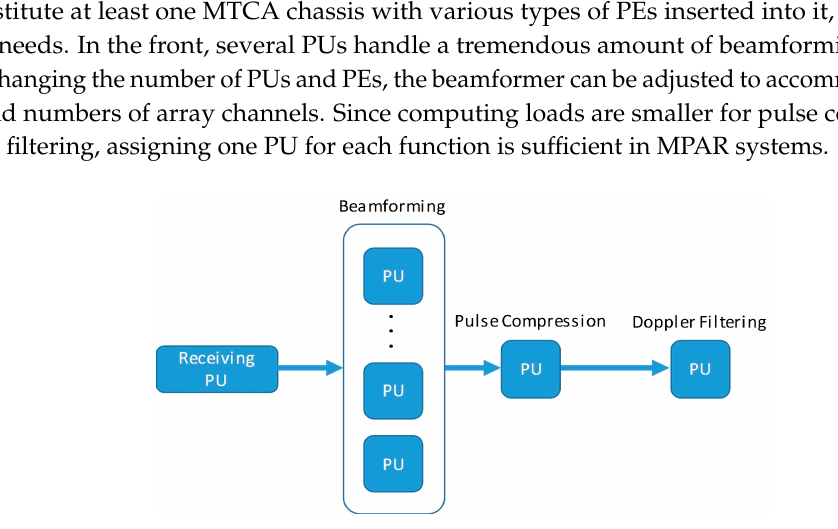
Figure 2. Illustration of the Micro Telecom Computing Architecture (MTCA) architecture in a backend system.